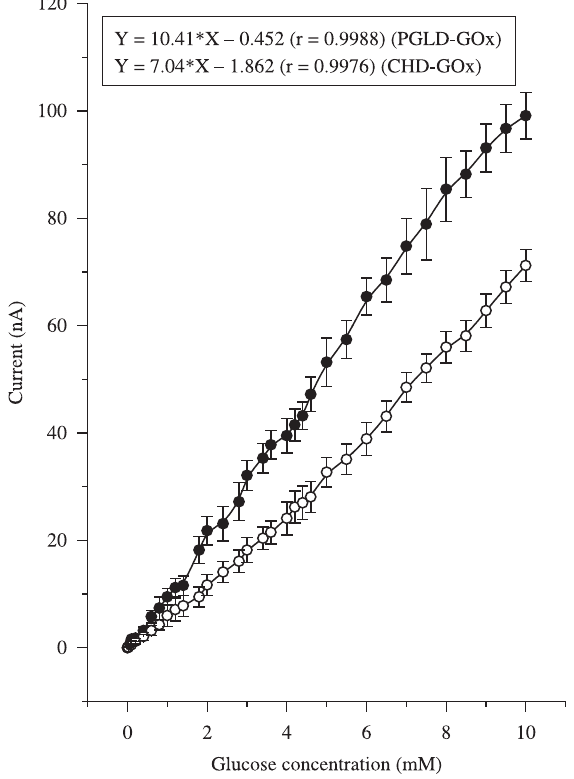
Figure 7. The calibration curve for glucose at the PGLD-GOx/PANINT´s ( ● ) and CHD-GOx/PANINT´s ( ○ ) in NaPBS 0.1 M, pH 7.4, 25 ºC; applied potential, 300 mV. Error bars: ± S.D., n =